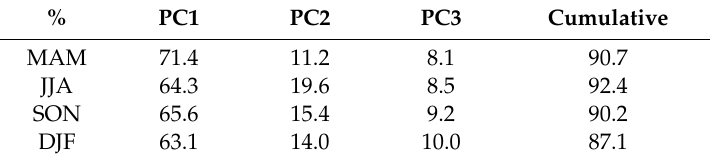
Table 1. Explained variance of leading principal components (PCs) for seasonal